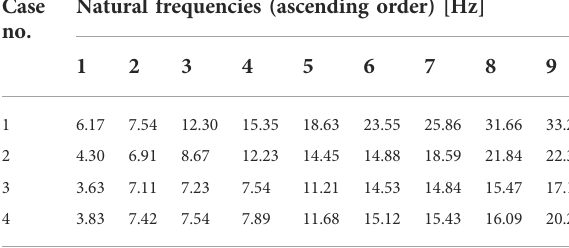
TABLE5Measurednaturalfrequenciesoftwocableswithintersection clamp in fi eld experiment. Case